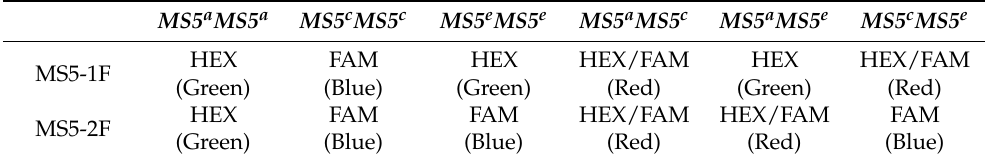
Table 3. PARMS primer sets for